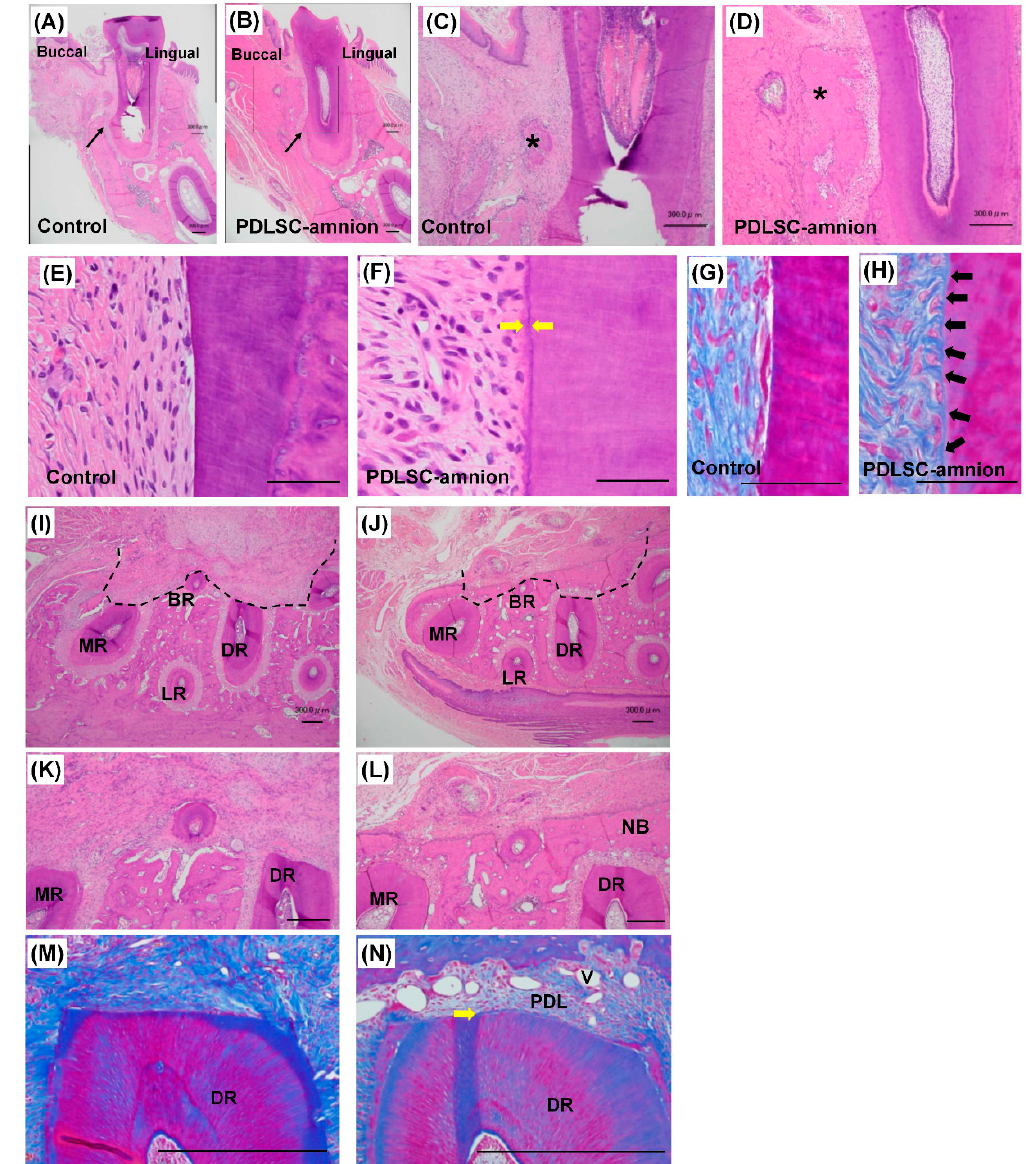
Figure 3. Histological analysis of periodontal tissues. Histological observation of periodontal tissues in rat periodontal defects four weeks after transplantation. Histological images are shown using long axial ( A – H ) and horizontal ( I – N ) sections at lower ( A , B , I , J ) and higher magnification ( C , D , E – H , K – N ). Sections were stained with hematoxylin and eosin ( A – F , I – L ) or azan ( G , H , M , N ). The boxed area in panels A , B are demonstrated in panels C , D , respectively. Close-up images of center of denuded root surface are shown in panels E – H . More bone formation was observed in the PDLSC-amnion group compared with control ( A – D , I – L ), and cementum-like thin layer of hard tissue was formed on the root surface in the PDLSC-amnion group ( F , N , yellow arrows). Collagen fibers originating perpendicular to the root surface were obvious in PDLSC-amnion group sections ( H , black arrows). The dotted line outlines the periodontal defect in horizontal sections ( I , J ). New formation of bone and PDL-like structure were prominent in the PDLSC-amnion group, while the defects were filled with collagen fibers in the control ( K , M ). The PDL space contained many blood vessels ( L , N ). *: new bone, black arrowhead: bottom of defect, yellow arrow: cementum-like tissue, black arrow: collagen bundles run from root surface, MR: mesial root, BR: buccal root, DR: distal root, LR: lingual root, NB: new bone, PDL: periodontal ligament, V: blood vessel, Bar = 300 µ m ( A – D , I – N ) and 50 µ m ( E – H